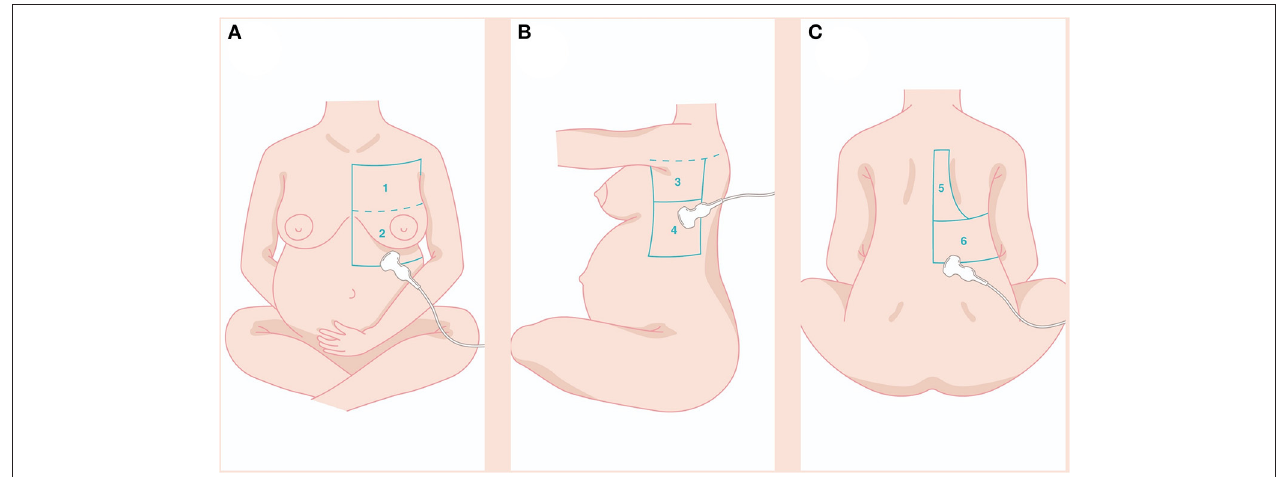
FIGURE 1 | The LUS score was calculated dividing each hemithorax into six regions and represented in the specific obstetric population (A–C) in the following zone: anterior-superior (I), anteroinferior (II), lateral-superior (III), lateral-inferior (IV), posterior-superior (V), posterior-inferior (VI). Details in the main text. LUS, lung